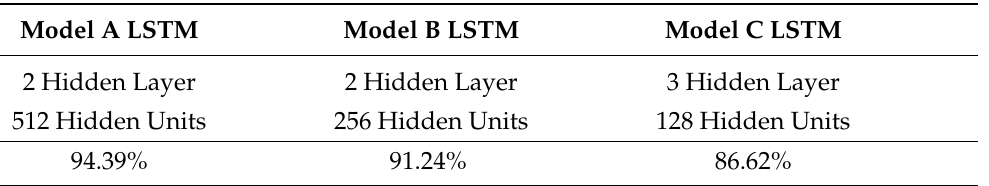
Table 4. Quantitative Comparison of different LSTM Models: this table shows a quantitative compar- ison of test accuracy different LSTM models trained to learn human pose. It proved that deep hidden state LSTM performs exceptionally well as compared to shallow models.